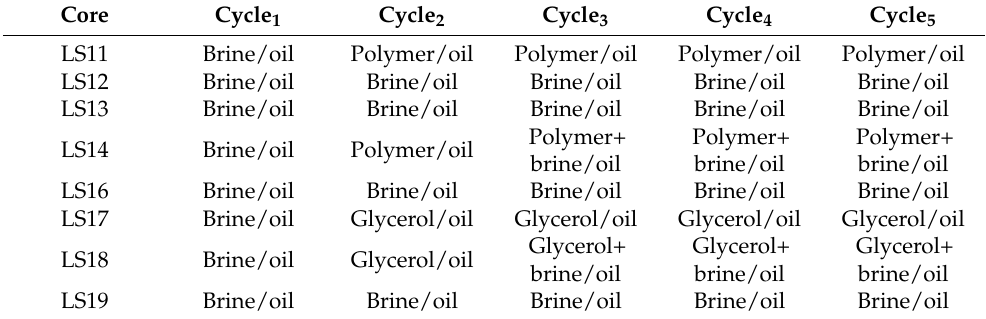
Table 2. Overview of fluid pairs used during each Amott–Harvey cycle. Note that the cores were also used in pairs of similar properties, and duplicate experiments were performed to evaluate repro- ducibility. Exemplified, core pairs L11/L17 (high K = 46–53 mD) and L14/L18 (low K = 22–24 mD) were compared after HPAM polymer (LS11 and LS14) and glycerol (LS17 and LS18) cycles. High viscous polymer and glycerol was displaced by brine before spontaneous imbibition in the third and consecutive cycles in core LS14 and LS18 to assess imbibition and wettability dependency on mobility. Core Cycle 1 Cycle 2 Cycle 3 Cycle 4 Cycle 5 LS11 Brine/oil Polymer/oil Polymer/oil Polymer/oil Polymer/oil LS12 Brine/oil Brine/oil Brine/oil Brine/oil Brine/oil LS13 Brine/oil Brine/oil Brine/oil Brine/oil Brine/oil Polymer+ Polymer+ Polymer+ LS14 Brine/oil Polymer/oil brine/oil brine/oil brine/oil LS16 Brine/oil Brine/oil Brine/oil Brine/oil Brine/oil LS17 Brine/oil Glycerol/oil Glycerol/oil Glycerol/oil Glycerol/oil Glycerol+ Glycerol+ Glycerol+ LS18 Brine/oil Glycerol/oil brine/oil brine/oil brine/oil LS19 Brine/oil Brine/oil Brine/oil Brine/oil